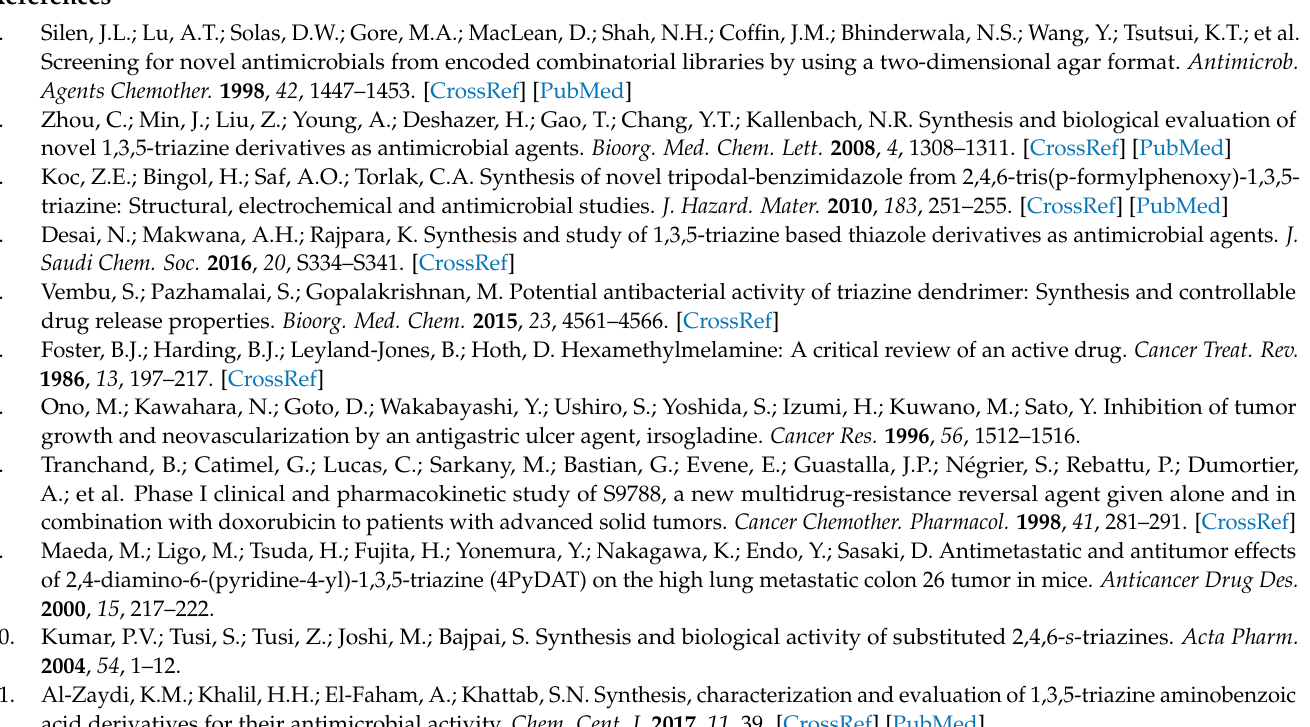
complex 1; Figure S3. Hirshfeld maps for the [Co(L)(H2O)2Br]Br complex; Table S1. Evaluation of the cytotoxicity of 1 against the A-549 cell line. Table S2. Evaluation of the cytotoxicity of 2 against the A-549 cell line; Table S3. Evaluation of the cytotoxicity of 3 against the A-549 cell line; Table S4. Evaluation of the cytotoxicity of 4 against the A-549 cell line; Table S5. Evaluation of the cytotoxicity of L against the A-549 cell line. Table S6; Evaluation of the cytotoxicity of 1 against the MCF-7 cell line; Table S7. Evaluation of the cytotoxicity of 2 against the MCF-7 cell line; Table S8. Evaluation of the cytotoxicity of 3 against the MCF-7 cell line; Table S9. Evaluation of the cytotoxicity of 4 against the MCF-7 cell line; Table S10. Evaluation of the cytotoxicity of L against the MCF-7 cell line; Table S11. Evaluation of the cytotoxicity of CoCl2 against the A-549 cell line; Table S12. Evaluation of the cytotoxicity of Co(NO3)2.6H2O against the A-549 cell line; Table S13. Evaluation of the cytotoxicity of CoCl2 against the MCF-7 cell line; Table S14. Evaluation of the cytotoxicity of Co(NO3)2.6H2O against the MCF-7 cell line. Examples can be found at